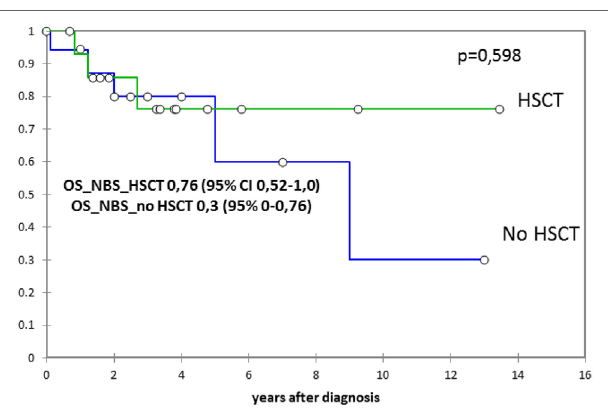
FigUre 3 | The probability of the overall survival since Nijmegen breakage syndrome (NBS) diagnosis in 15 patients who underwent hematopoietic stem cell transplantation (HSCT) and in 20 non-transplanted patients (expressed as percentage ± SD). Probability of overall survival was estimated by the Kaplan-Meier product limit and were expressed as percentage ± standard deviation. The two-sided log-rank test was used for comparisons.